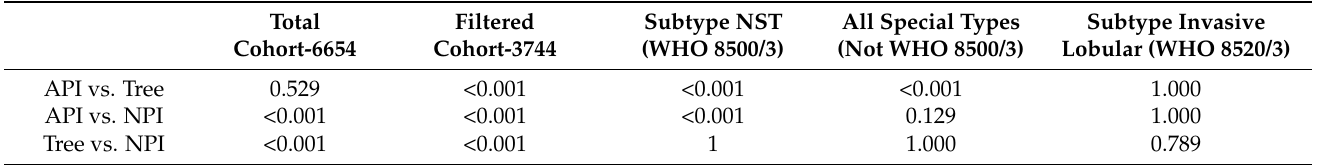
Table 5. Comparison of the iAUCs of the API, the survival tree model and the NPI for the test sets of the different cohort using Wilcoxon rank sum tests for dependent